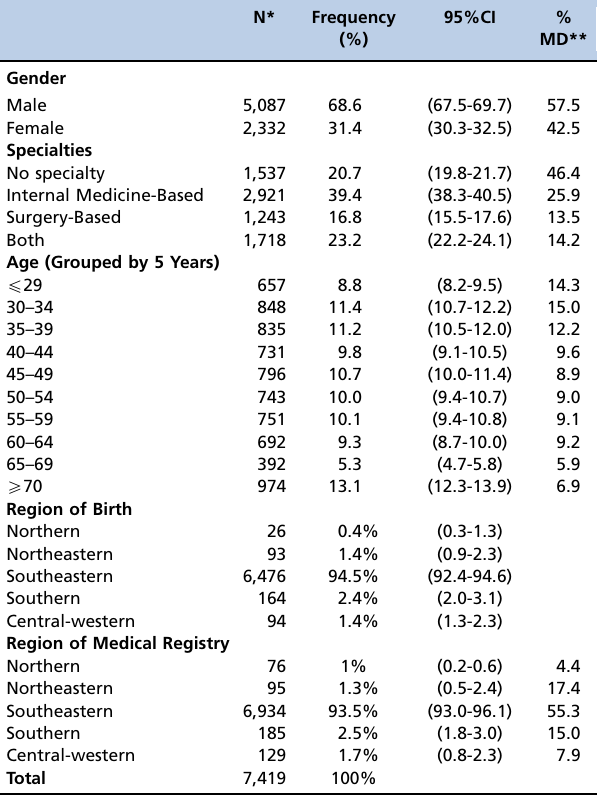
Table 1 - The statistical description of physicians who graduated from FMUSP and their specialties. The percentages presented correspond to the total number of physicians and the total number of specialists,